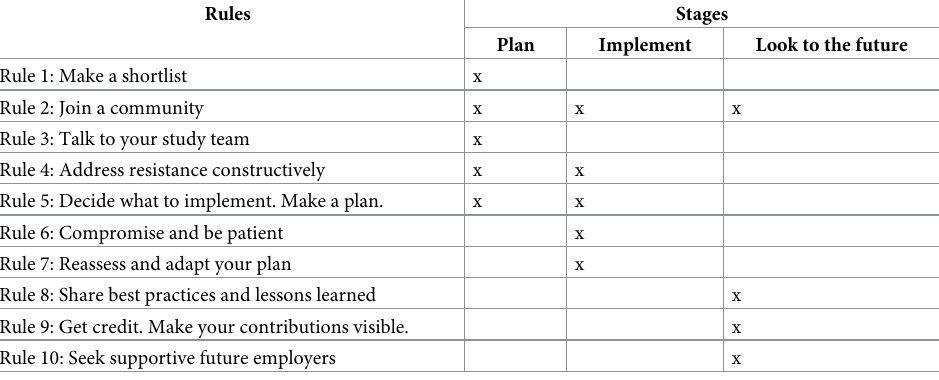
Table 1. Phases of implementing practices after a robust research course. These 10 simple rules can be organized into three phases of the implementation process. Some steps are relevant at all phases. Scientists may need to revisit some phases or adapt their plans as they encounter barriers and challenges, or decide to implement additional robust research practices in their studies. Rules Stages Plan Implement Look to the